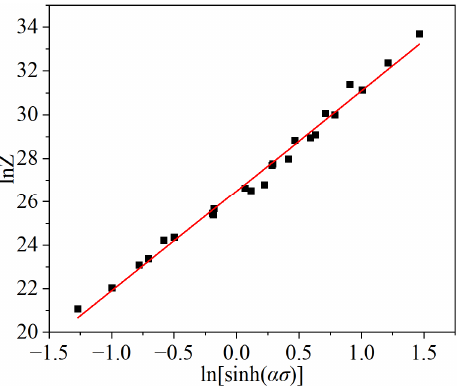
Figure 8. Relationship between ln Z and ln [ sinh ( ασ )] . Under high temperature conditions, strain not only has a significant effect on flow stress, but also on the material constant ( α , n , Q and ln A ), which is a polynomial function of strain in the entire strain range, such as Equation (15), which introduces the influence of strain on the constitutive equation.